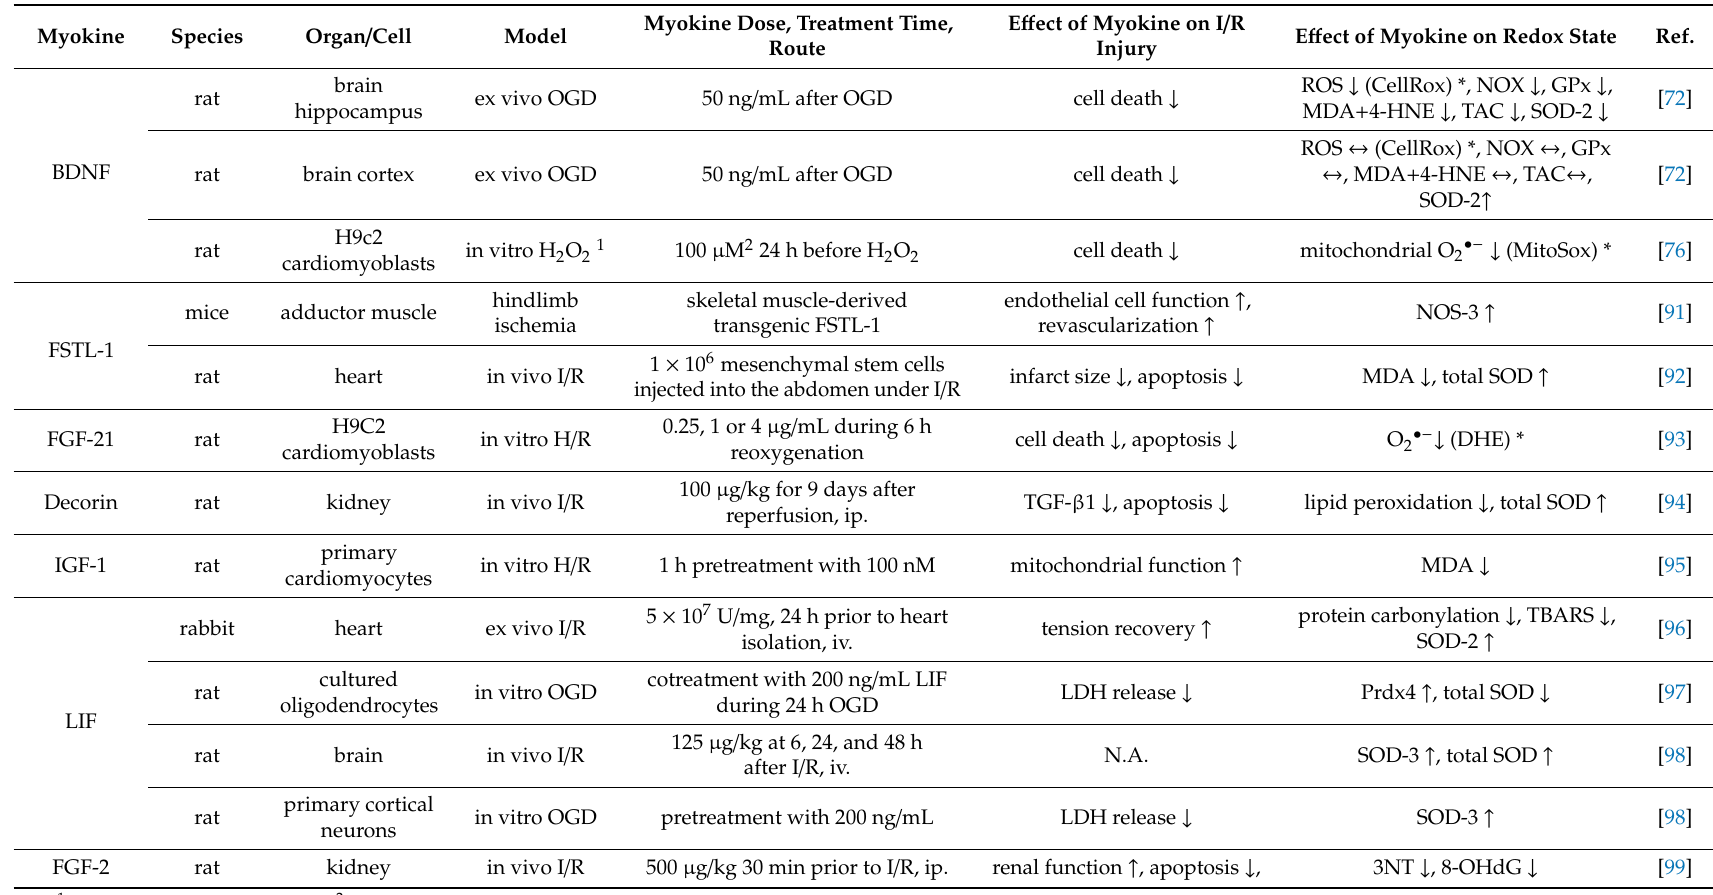
Table 4. E ff ect of di ff erent myokines on redox state in settings of I /